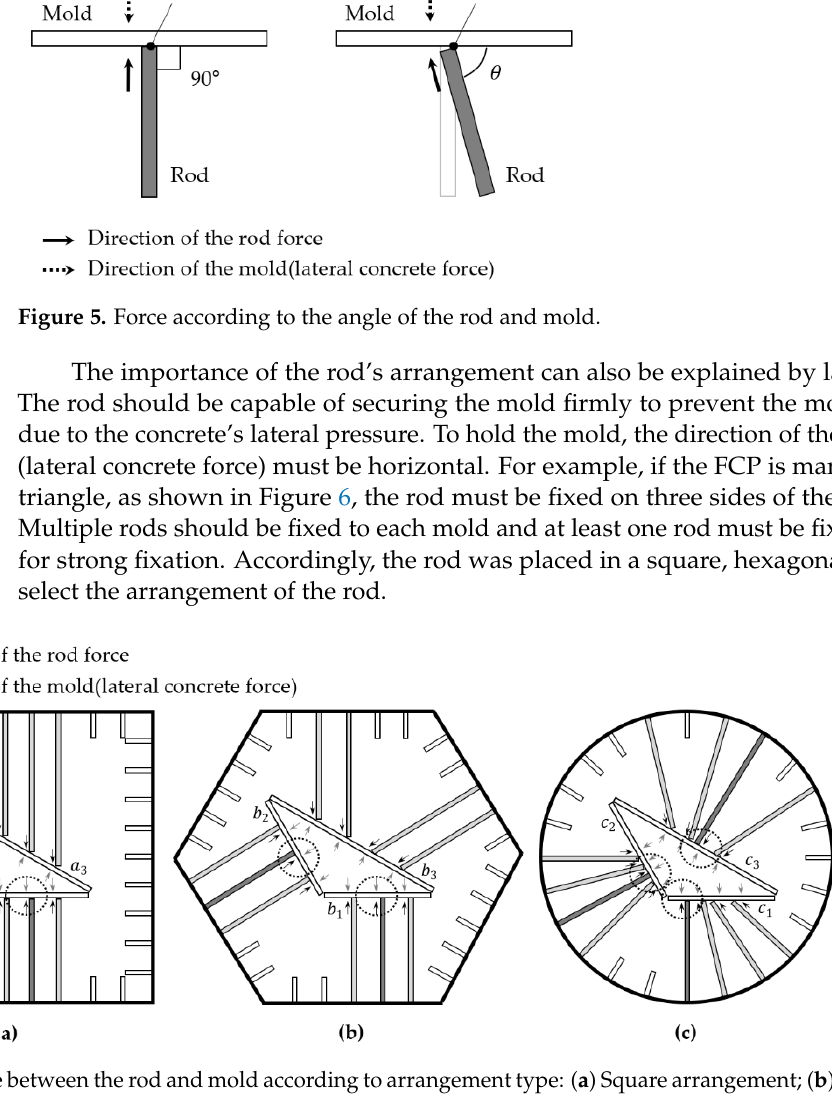
Figure 6. Direction of force between the rod and mold according to arrangement type: ( a ) Square arrangement; ( b ) Hexagonal arrangement; ( c ) Circle arrangement.